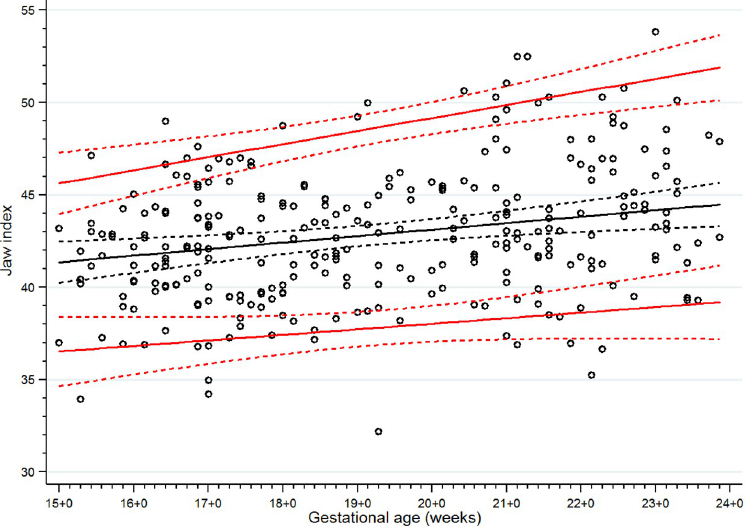
Fig 7. Scatter plot of jaw index along gestational age. Solid lines represent the jaw index values in the 5th, 50th and 95th percentiles, Dashed lines represent the 95% confidence interval for each given percentile.